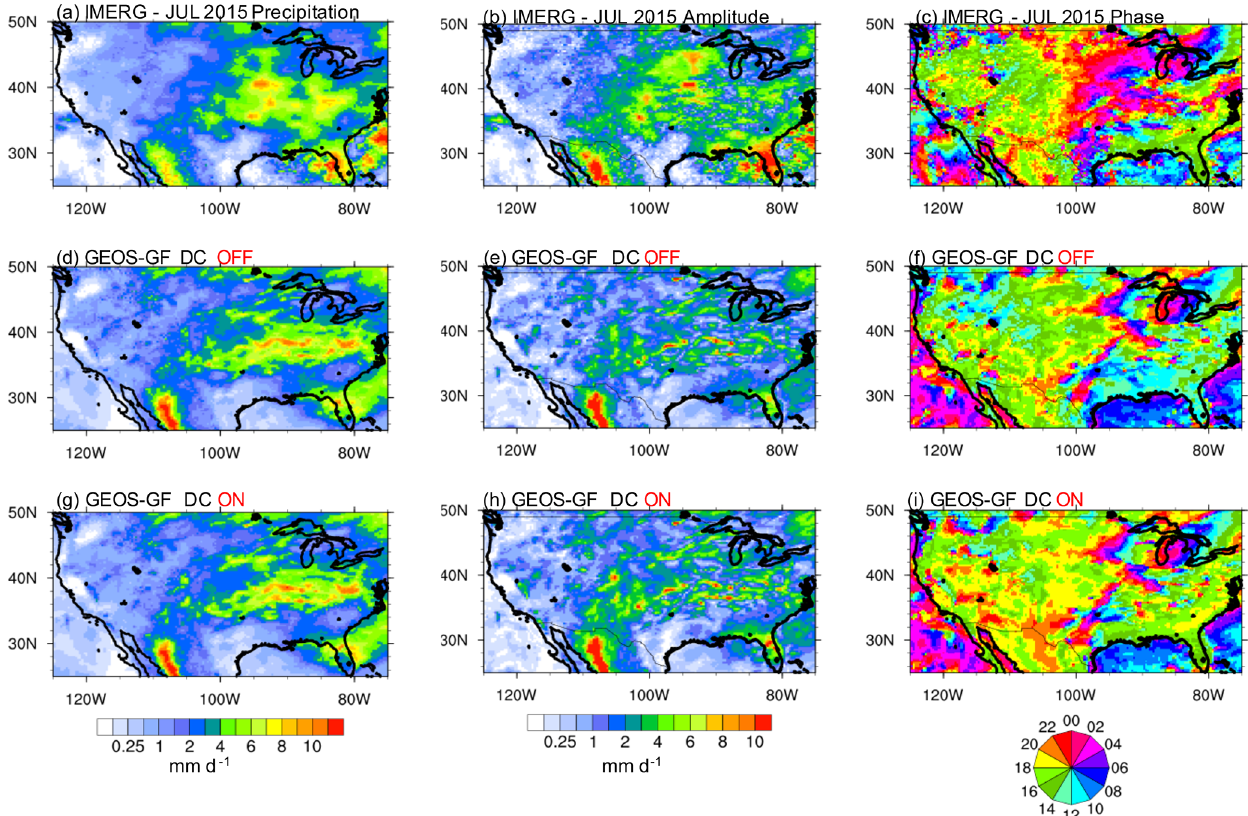
Figure 17. The July 2015 monthly mean precipitation, amplitude, and phase of the diurnal harmonic over the contiguous United States and part of the neighboring countries. The top panels (a–c) show the quantities of the GPM IMERG retrieval. In the middle (d–f) and lower rows (g–i) , panels show model simulations with the diurnal cycle closure turned off and on,